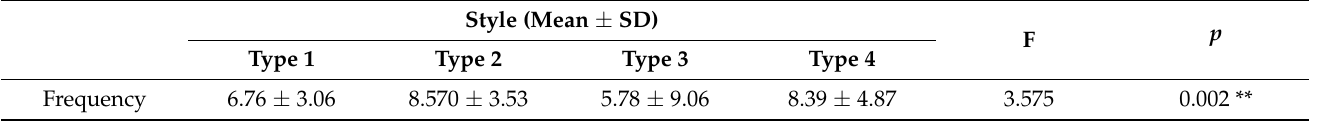
Table 9. Analysis of variance for key-style saccades.